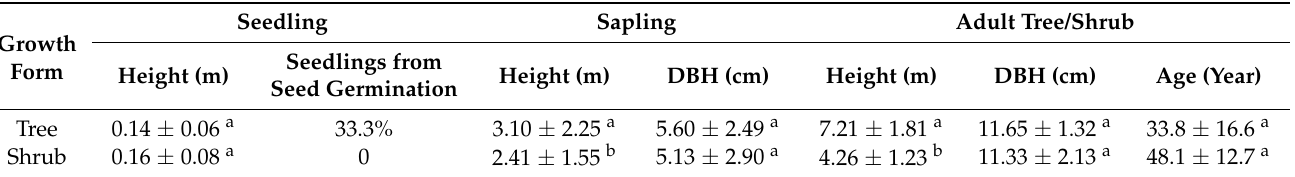
Table 1. Sample plot overview. Diameter at breast height (DBH), tree height, and adult tree age of Quercus mongolica Fisch. ex Ledeb. are shown at different growth stages (seedling, sapling, adult trees) of different growth forms.